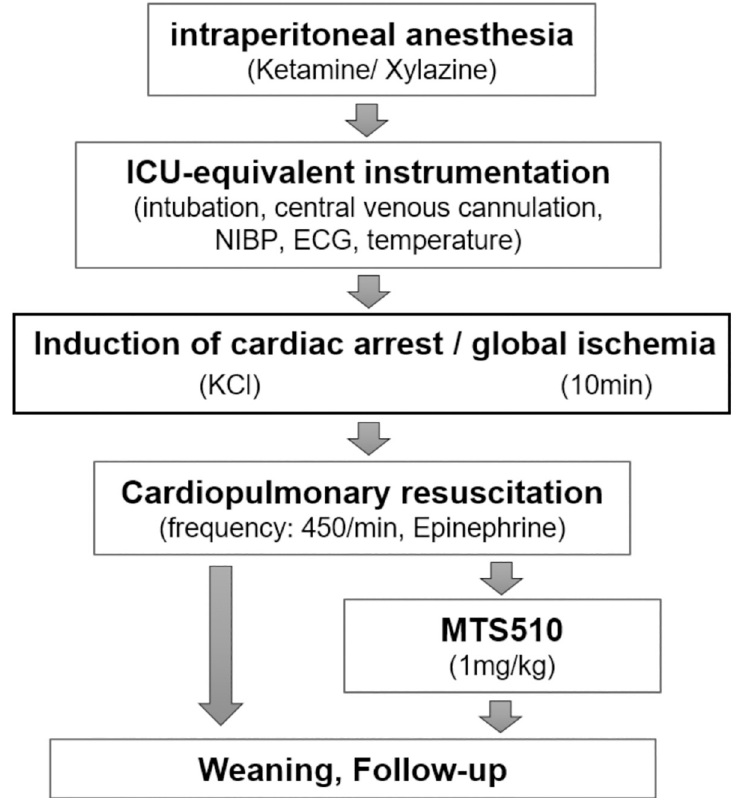
Fig 1. Protocol of cardiac arrest induction and cardiopulmonary resuscitation. Abbreviations: ICU intensive care unit, NIBP non-invasive blood pressure, ECG electro cardiogram, KCl potassium chloride.